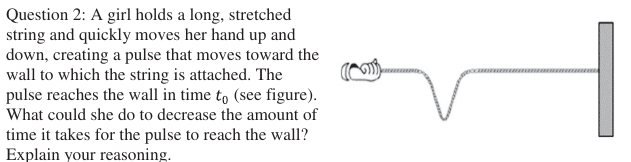
FIG. 2. Interview questions used in part 1 of this